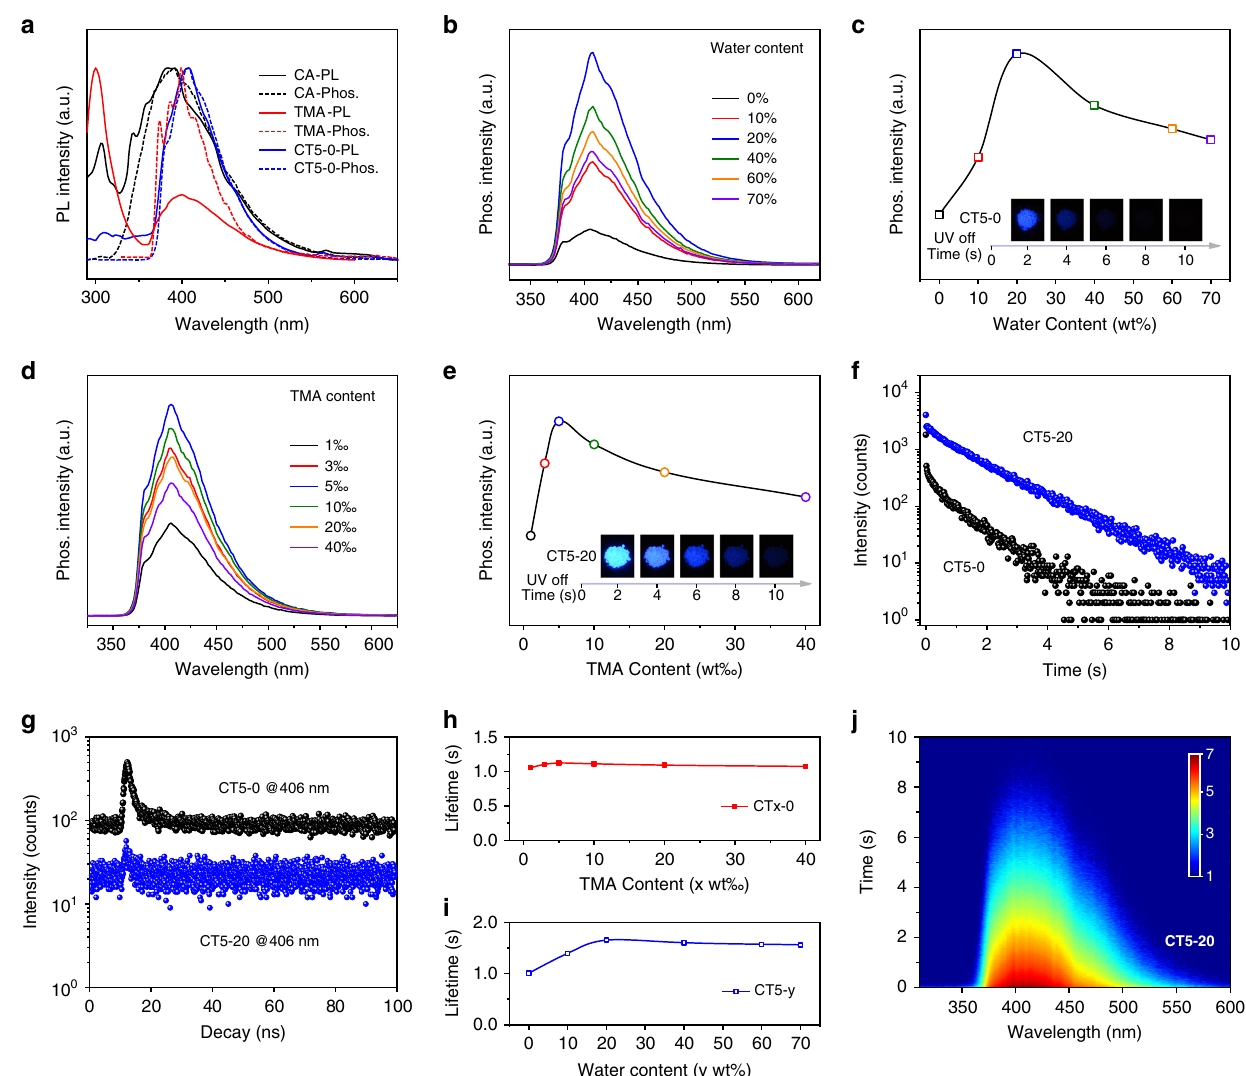
Fig. 2 Photophysical properties of CT powders at room temperature. a Steady-state PL (solid line) and phosphorescence (dash line, delay 30 ms) spectra of CT5-0 powder at 298 K as well as TMA in ethanol (10 µ M) and CA powder at 77 K. b – e Phosphorescent spectra ( b , d ) and 406 nm emission intensities ( c , e ) of CT5-y with various water contents ( y wt%) ( b , c ) and dry CTx-0 powder with various doping concentrations ( x wt ‰ ) of TMA ( d , e ). Insets: photographs of CT5-0 and CT5-20 taken after removing the excitation of 254 nm UV light. f , g OURTP ( f ) and fl uorescence ( g ) decay curves of CT5-0 (black) and CT5-20 (blue) at 406 nm. h , i OURTP lifetimes of CTx-0 with various TMA concentrations ( h ) and CT5-y with various water contents ( i ). j Time-resolved emission scanning spectrum of CT5-20. The excitation wavelength is 248